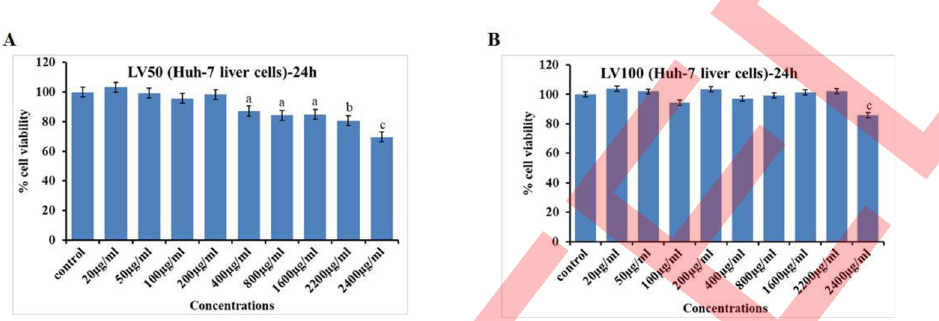
Fig 1. Cell viability in Huh-7 liver cells treated with methanol extracts of Lavandula angustifolia 50% (1A) and 100% concentration (1B) at 24 h after incubation. The data are presented as means ± SE of four different experiments. The means which do not share a common letters differ significantly from control.